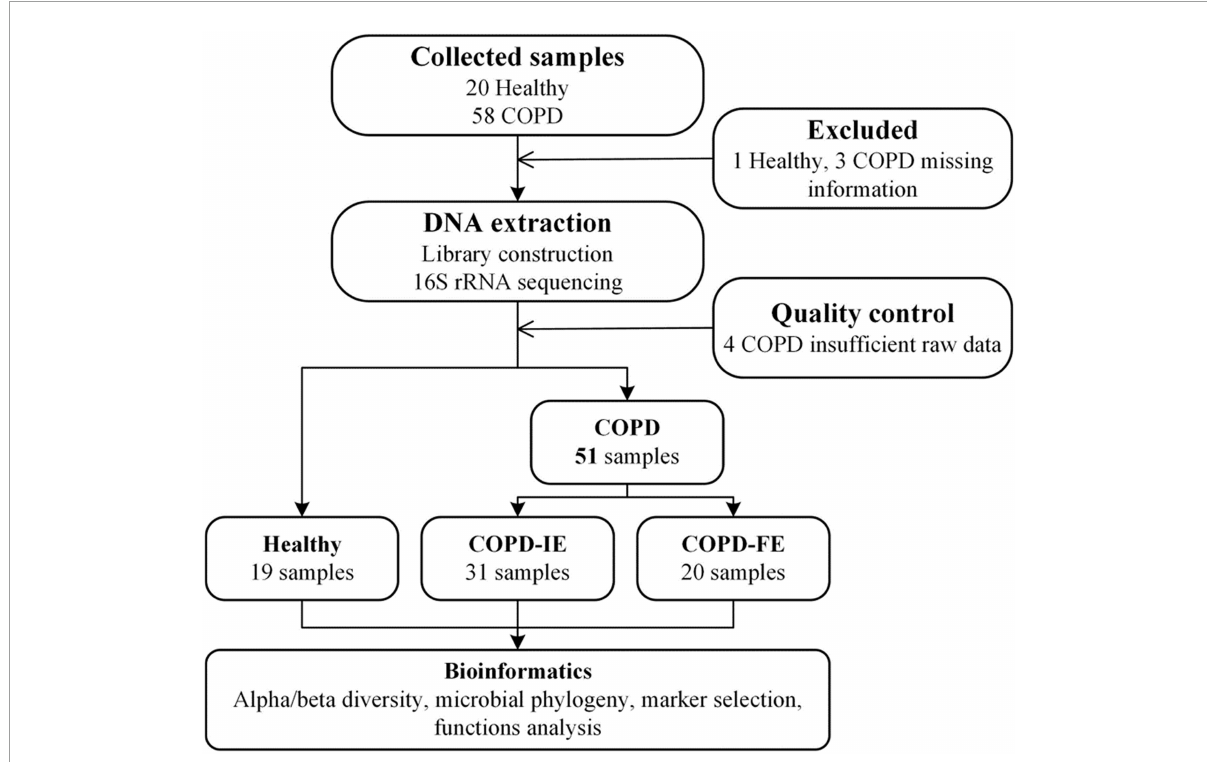
FIGURE1 Study design and flow diagram (Mirzayi et al., 2021). A total of 78 subjects were included. After exclusion procedures and data quality controls, 19 healthy samples, 31 COPD-IE samples, and 20 COPD-FE samples were included for bioinformatic analysis. COPD, Chronic obstructive pulmonary disease; COPD-IE, COPD with infrequent exacerbations; COPD-FE, COPD with frequent